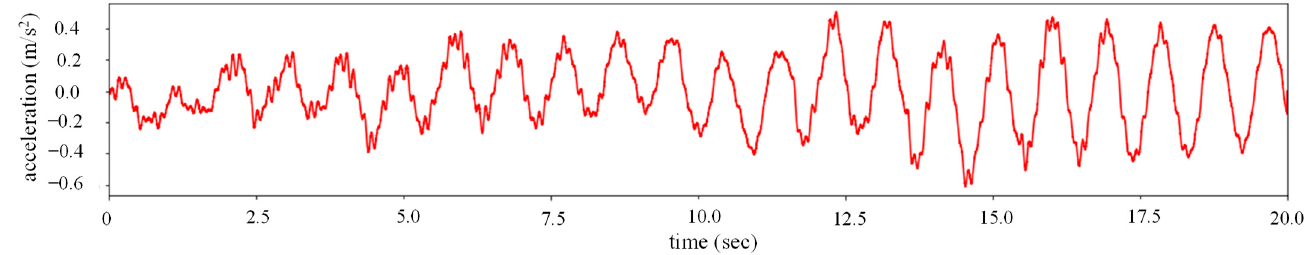
Figure 28. The output of the third accelerometer.